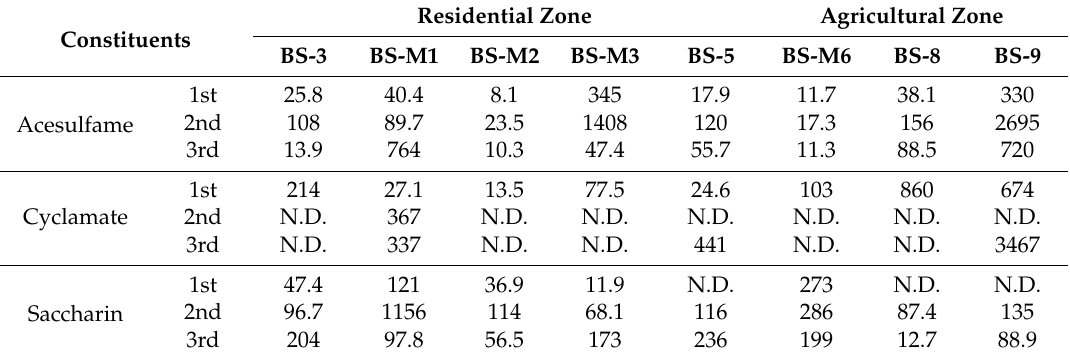
Table 6. The concentrations of artificial sweeteners and agrichemicals (unit: ng/L). Constituents